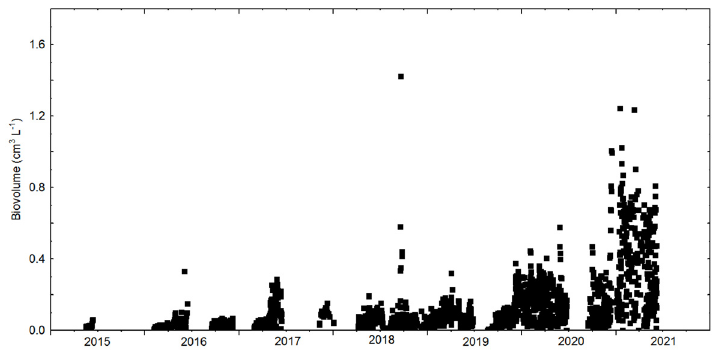
Figure 13. Biovolume from all reactors 2015–2021.